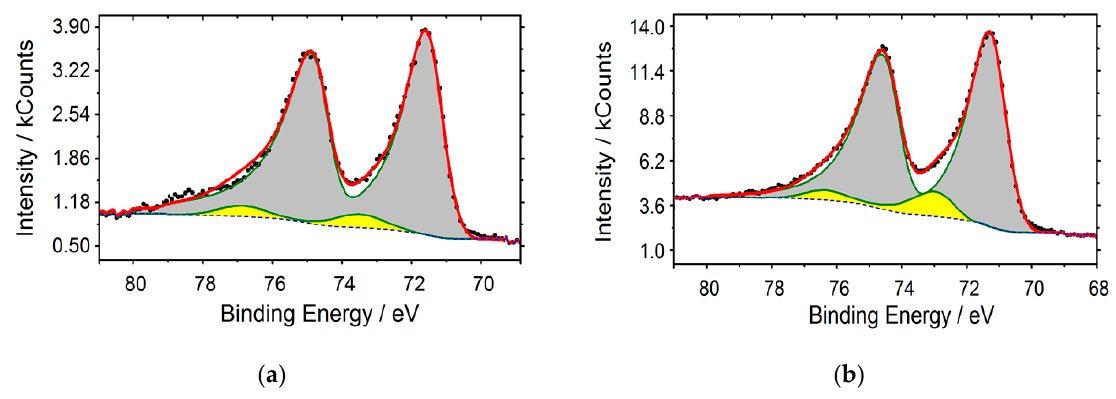
Figure 1. Pt4f XPS spectra of platinum deposited on carbon nanotubes: ( a ) Pt/CNT HNO3 ; ( b ) Pt/CNT HNO3-N .